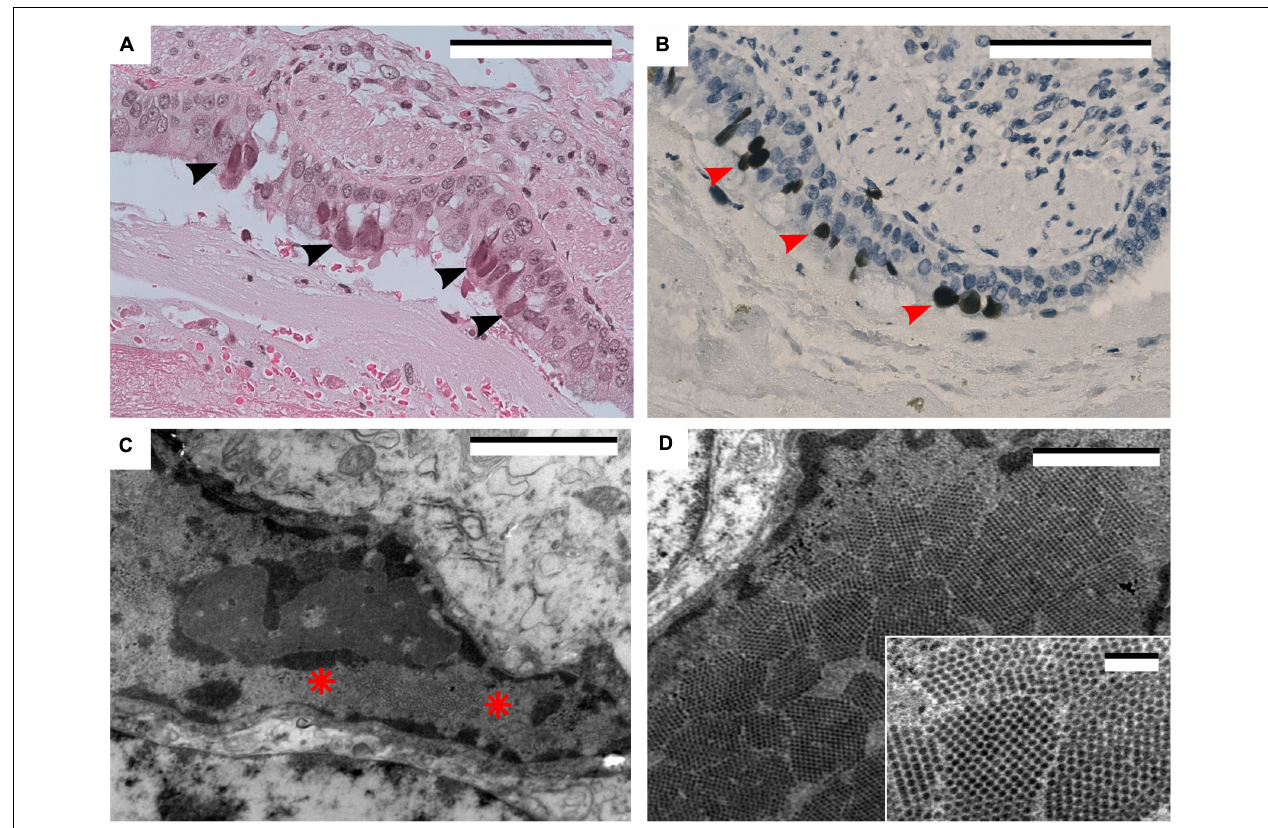
FIGURE 2 | (A) Hematoxylin and eosin. Ciliated bronchial epithelial cells with amphophilic nuclear inclusions (arrowheads). Scale bar: 100 µ m. (B) Polyomavirus BK immunohistochemistry. Same area as panel (A) , showing positive staining in the nuclear inclusions (arrowheads). Scale bar: 100 µ m. (C) Electron micrograph of an infected cell containing intranuclear inclusions (between asterisks). Scale bar: 2 µ m. (D) Intranuclear icosahedral inclusions. Scale bar: 1 µ m. Inset: Note the 40 nm particles characteristic of the polyoma virus group. Scale bar: 200 nm.